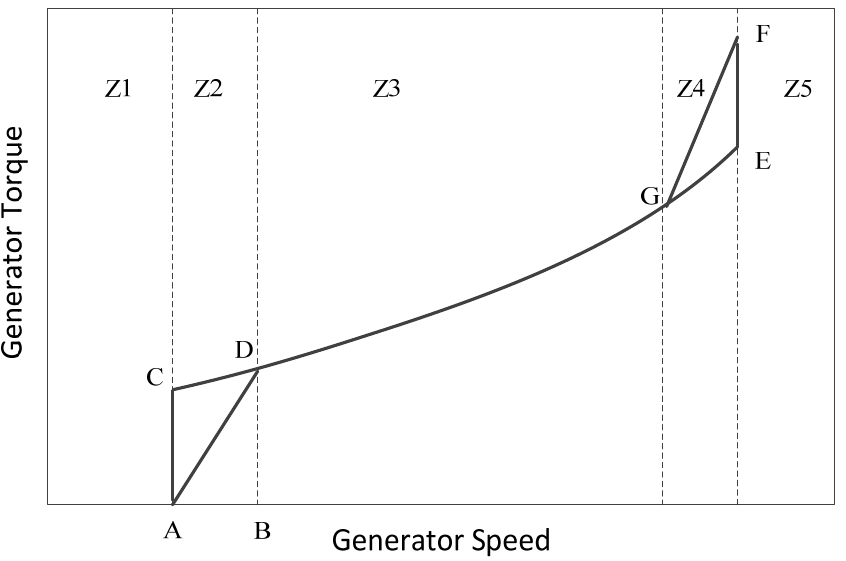
Figure 5. The speed-torque characteristic curve of a variable-speed constant-frequency generator. Figure 5. The speed ‐ torque characteristic curve of a variable ‐ speed constant ‐ frequency generator. The rotor speed is controlled by the equation of motion given by Equation (18), while the blade-pitch angle can be controlled by Equation (19) [25]: